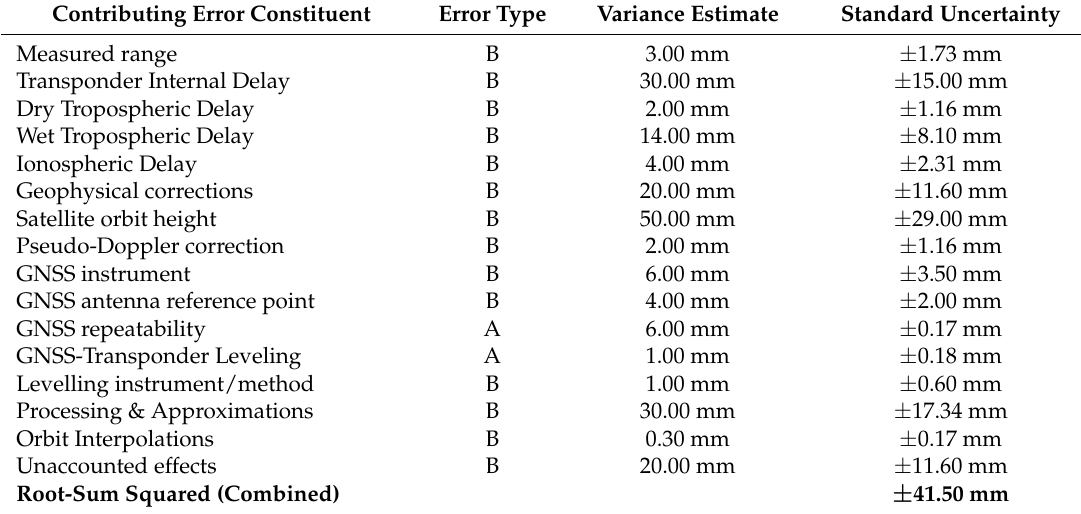
Table 1. Uncertainty budget for the transponder calibration, following the International Standards Organization “Guide to the Expression of Uncertainty in Measurement”